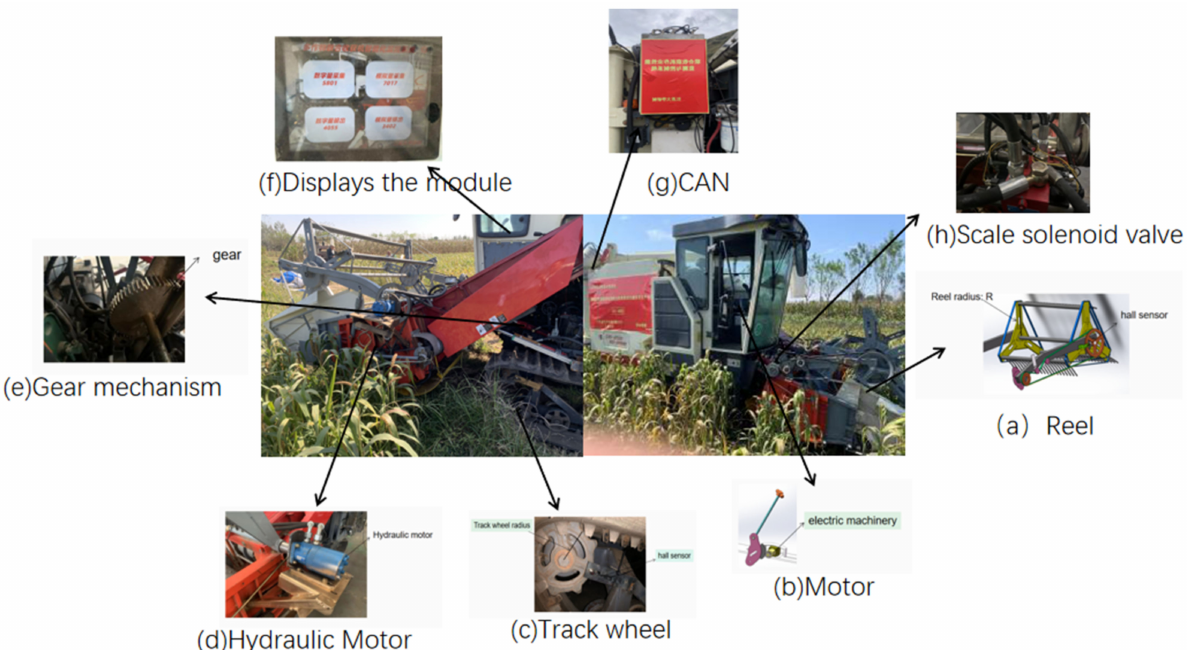
Figure 1. The 3D transformation diagram and the physical diagram of pulling reel and forward speed.